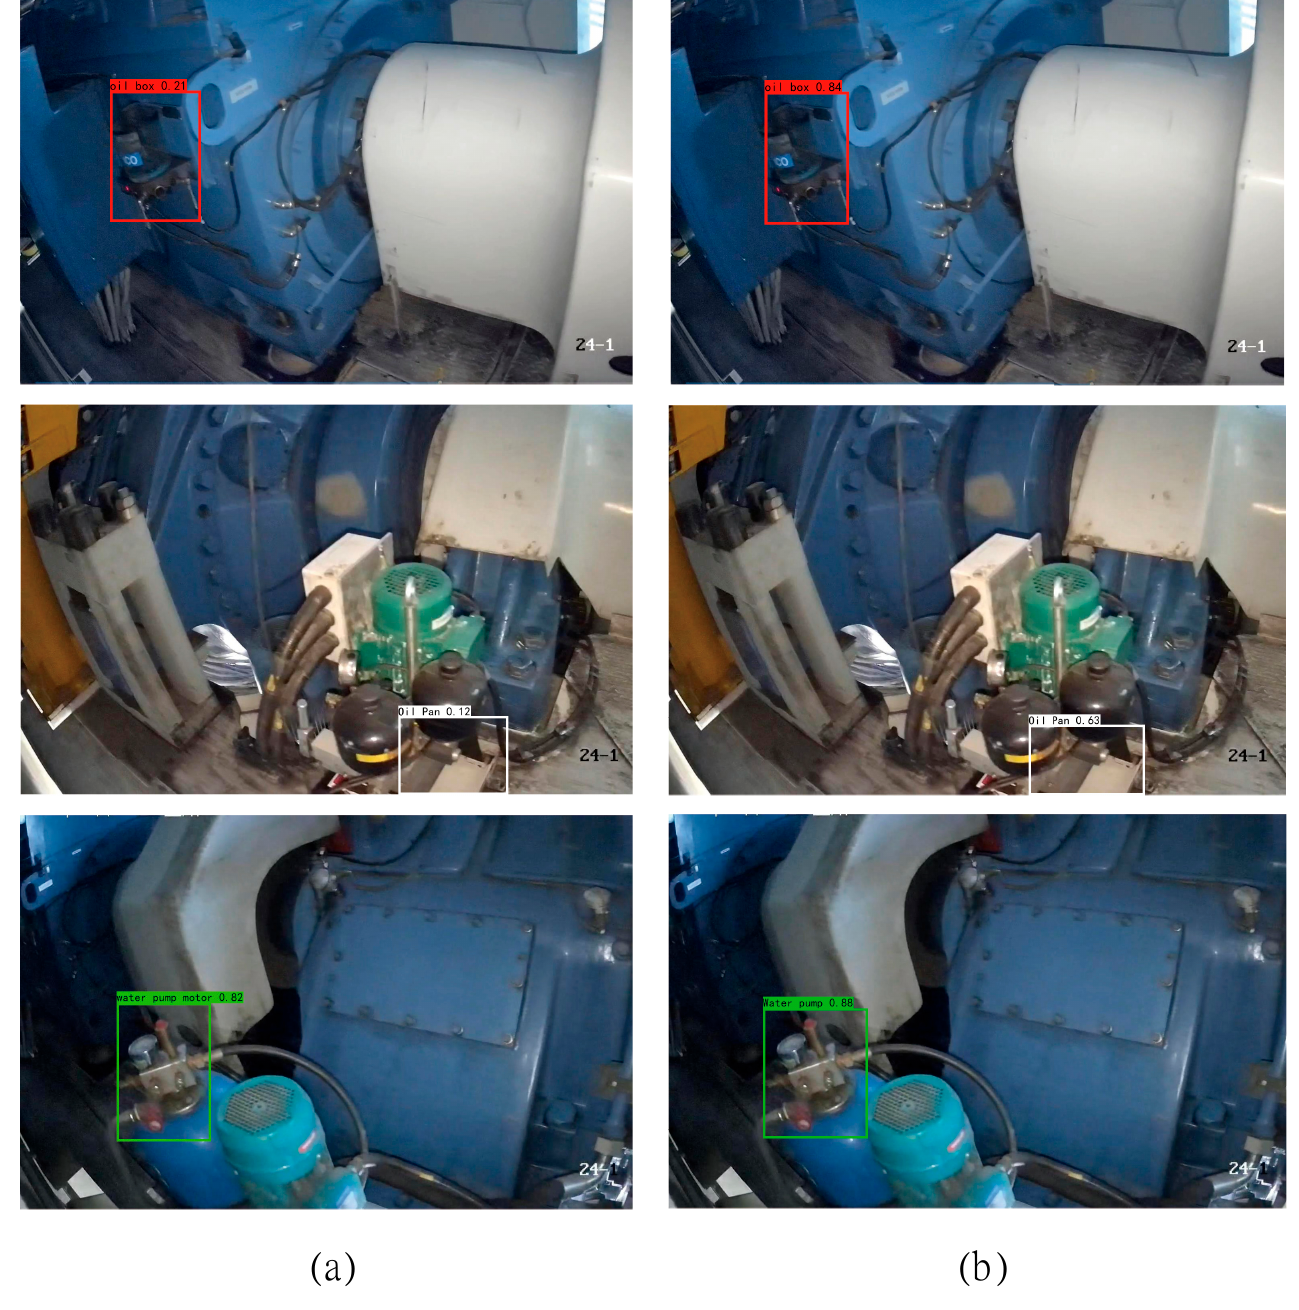
Figure 6. Detection results of ( a ) YOLOX-Nano before improvement, and ( b ) YOLOX-Nano after improvement. Table 2. Comparison of different detection